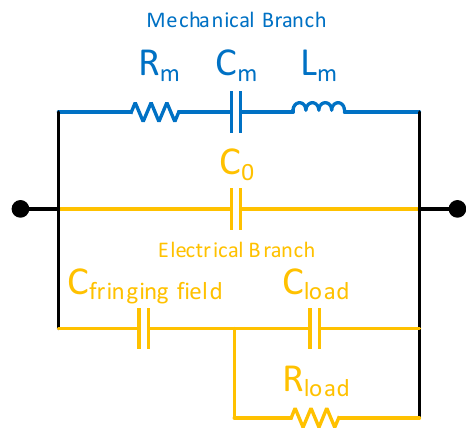
Figure 9. The equivalent circuit of the Pt-GO-LCM.